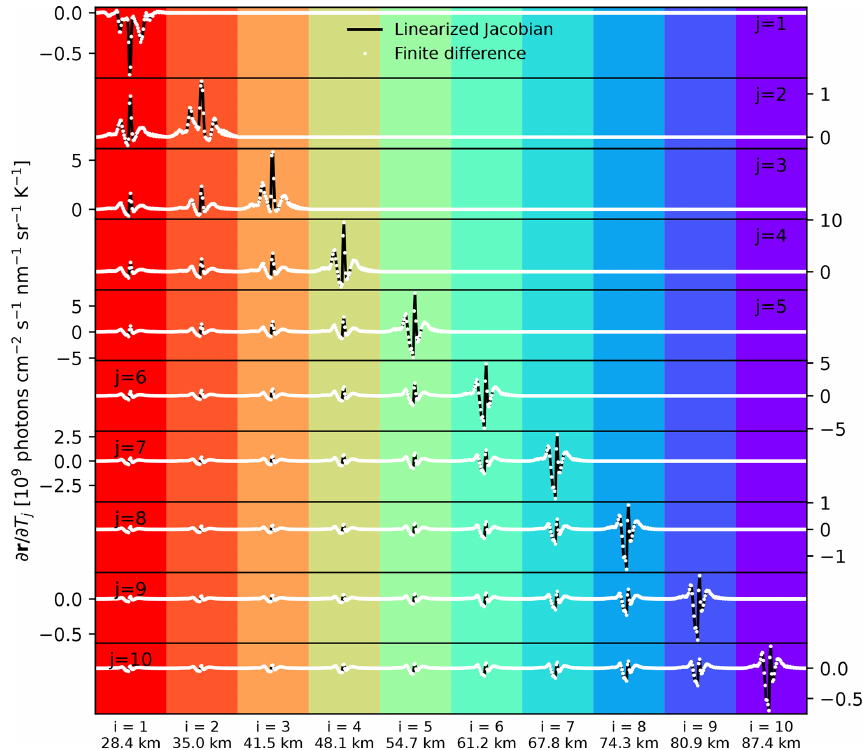
Figure B1. Validation of analytical Jacobians of radiance with respect to temperature, based on Eq. (B1) (black lines), with finite difference (white dots). Each vertical column represents one limb view (fixed i ) over all layers (different j ). In total, 10 tangent views (i.e., N = 10) are included using a single vertical sounding at the O 2 1 (cid:49) band from SCIAMACHY orbit no. 41011 on 3 January 2010. Only Jacobians of layers above the tangent point are